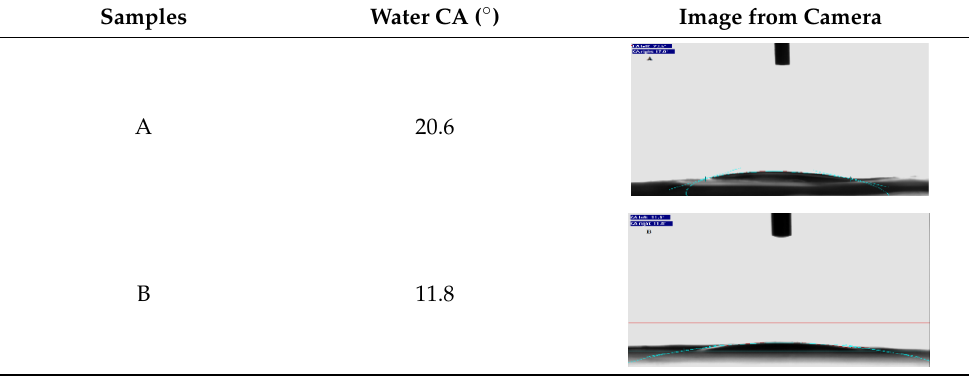
Figure 3. XRD spectra of ( A ) untreated, ( B ) atmospheric-air plasma-treated gelatin nanofibers.